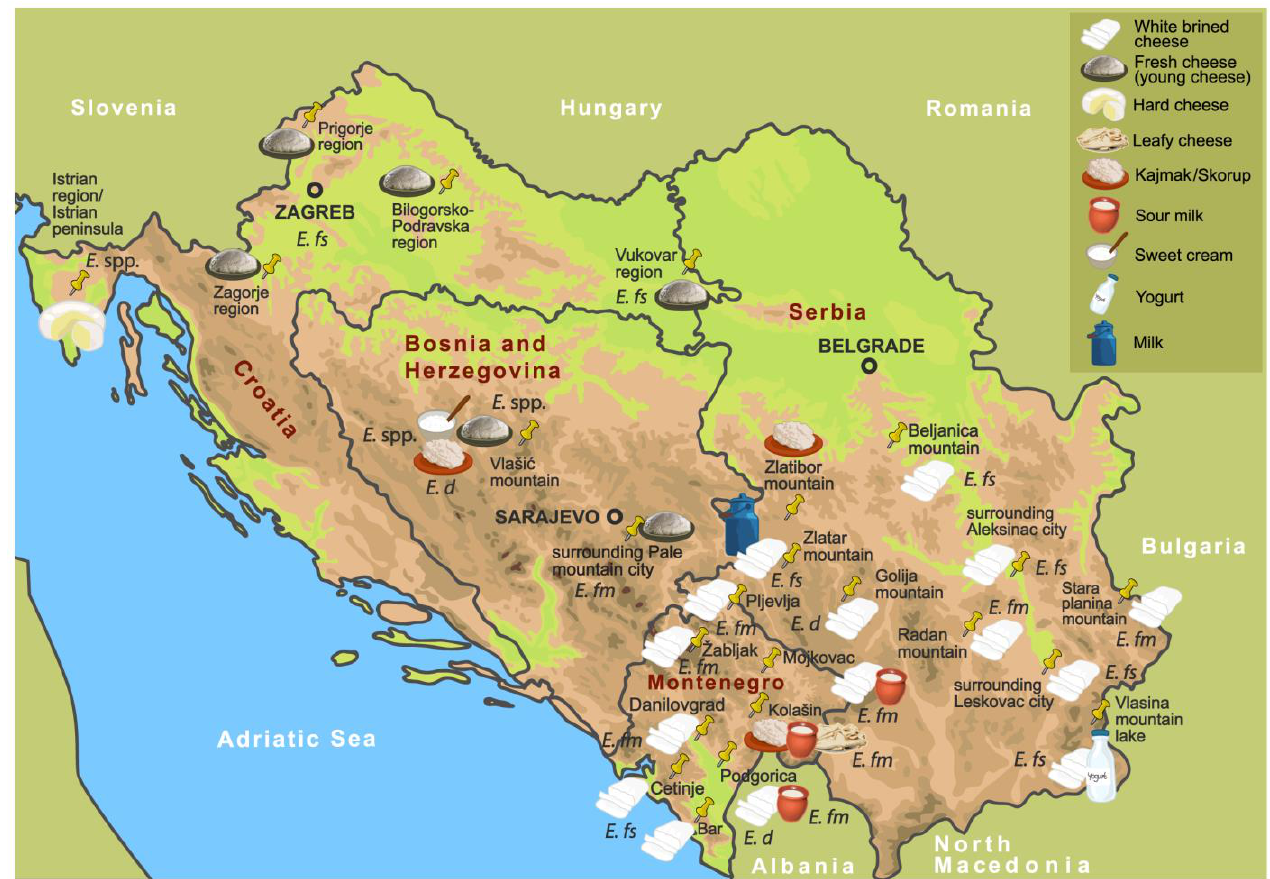
Figure 1. Artisanal raw milk dairy products manufactured in the region of Western Balkan Countries as a source of Enterococcus spp. Note: Most prevalent Enterococcus spp. in certain geographical localities: E . spp., Enterococcus species; E . fm , Enterococcus faecium ; E . fs , Enterococcus faecalis ; E . d , Enterococcus durans [11,54].